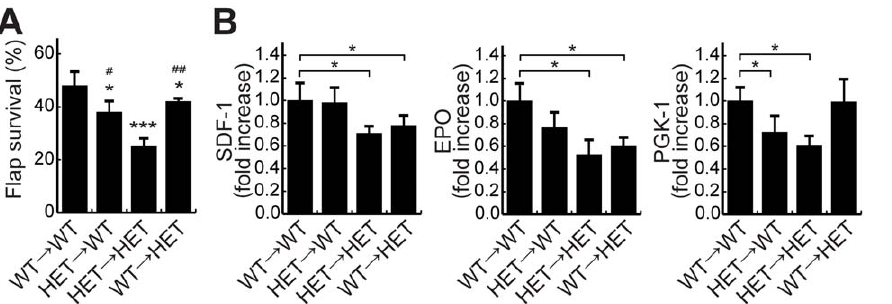
Figure 7. Effect of bone marrow cell expression of HIF-1 a on skin flap survival. A, Percentages of skin flap survival were calculated in WT and HET mice reconstituted with bone marrow from either WT or HET donor mice. Values are means 6 SEM. * P , 0.05, *** P , 0.001 vs. WT reconstituted with bone marrow from WT mice. # P , 0.05, ## P , 0.01 vs. HET reconstituted with bone marrow from HET mice. B, Transcript levels of HIF-1 target genes were assessed by qRT-PCR analysis at the ischemic skin flap on postoperative day 1 in bone marrow cell-transplanted mice (n=6). Values are means 6 SDM. * P , 0.05.